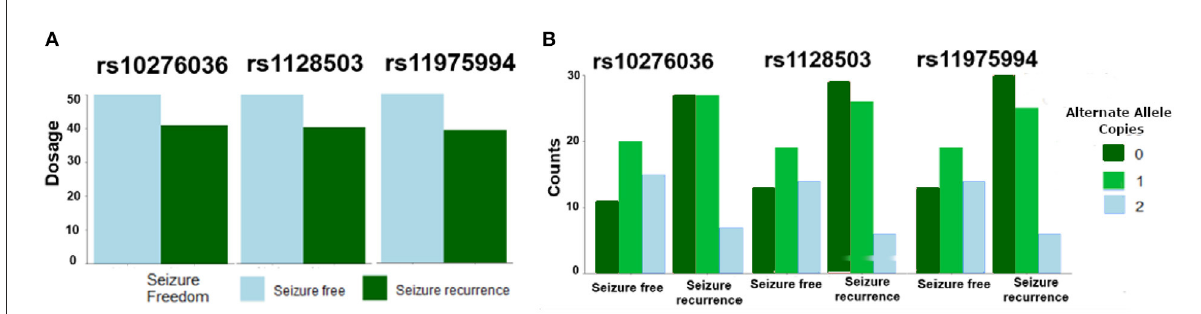
FIGURE1 Single nucleotide polymorphisms (SNPs) in ABCB1 were associated with likelihood of post-operative seizure recurrence. (A) An increase in allelic dosage of alternate alleles (sum of the number of alternate alleles) in the post-operative seizure-free subset of patients was observed compared to the seizure-recurrent subset for SNPs rs10276036, rs1128503, rs11975994. (B) Depicts the number of alternate allele copies by post-operative seizure outcome and by